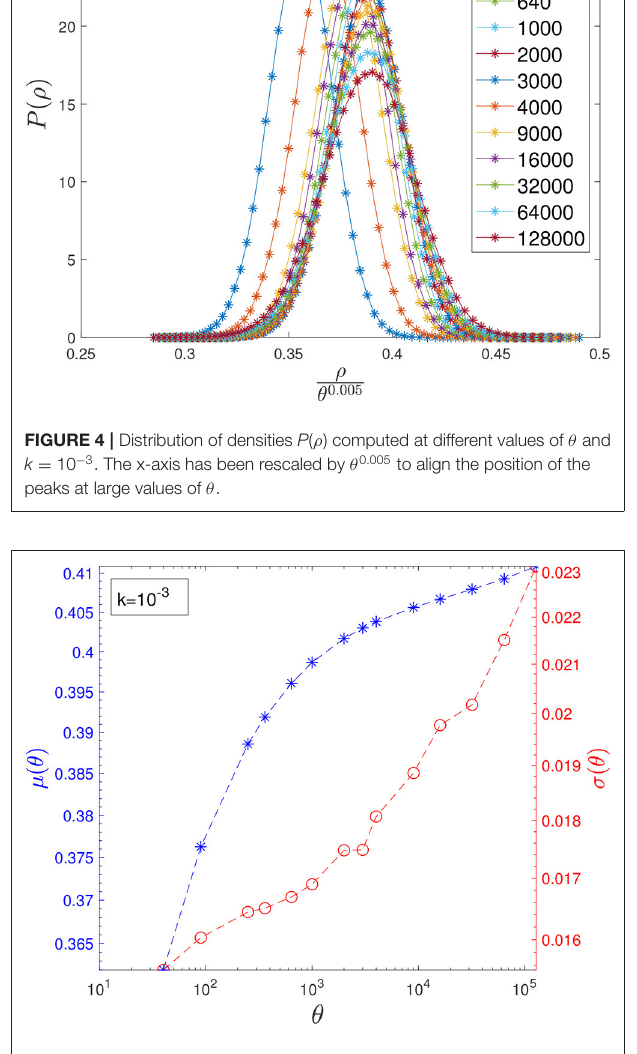
should produce a standard then plotting P ( ρ ) σ ( θ ) vs. ρ − µ σ normal distribution for systems at θ & 10 4 . To estimate the asymptotic behavior, we used the last six data points for µ ( θ ) and the last three data points for σ ( θ ) in Figure 5 , finding